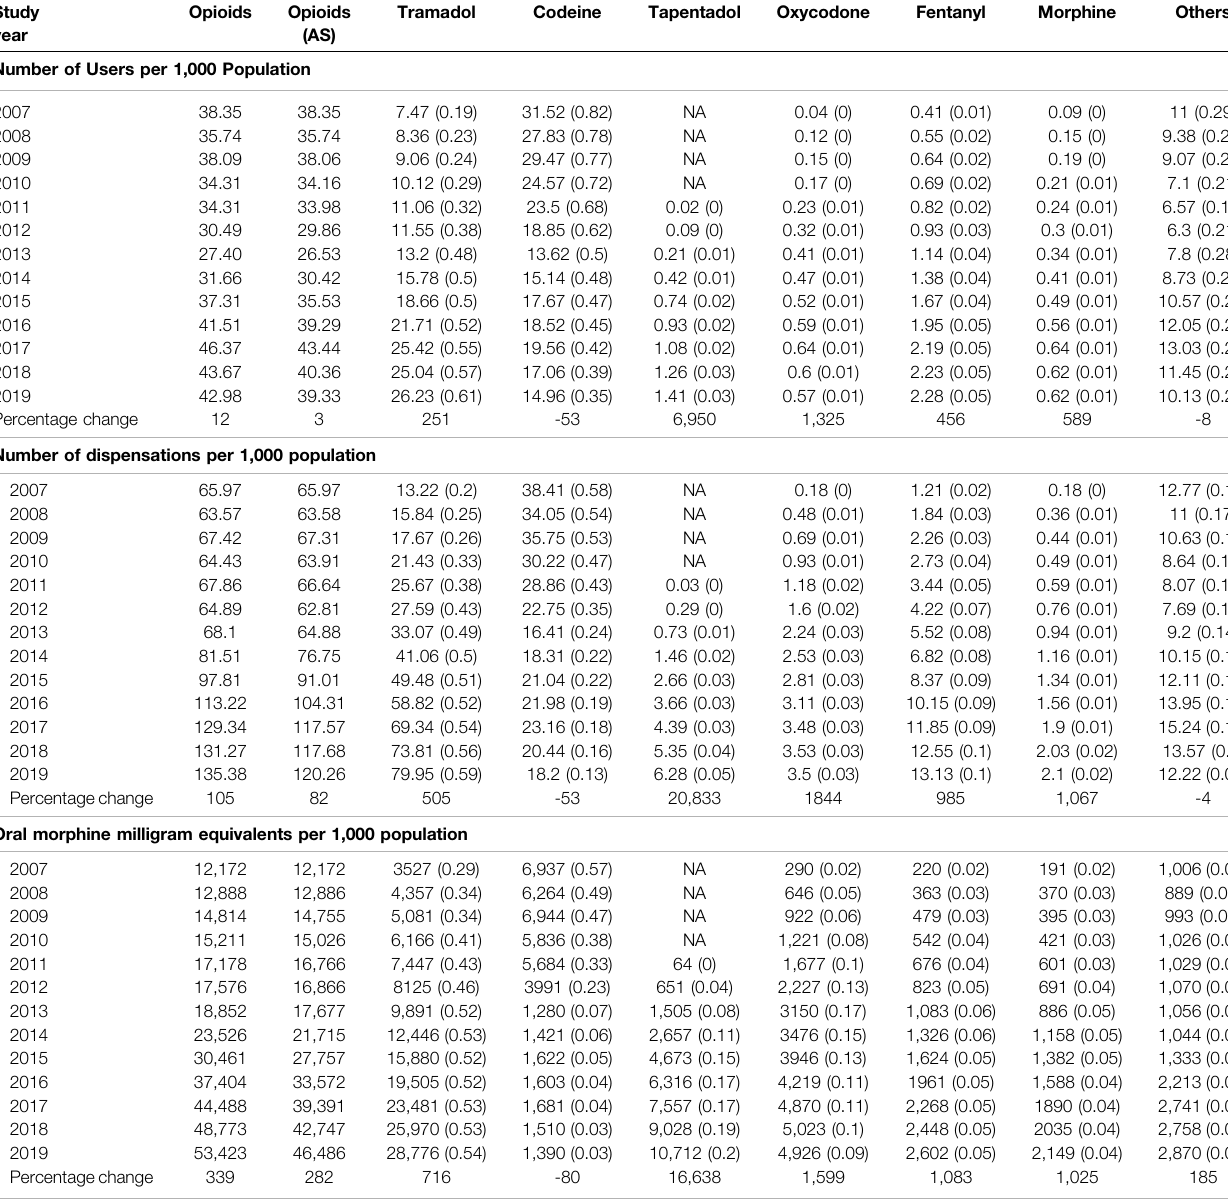
TABLE 1 | Use of opioids and their subtypes, measured by different metrics from 2007 to